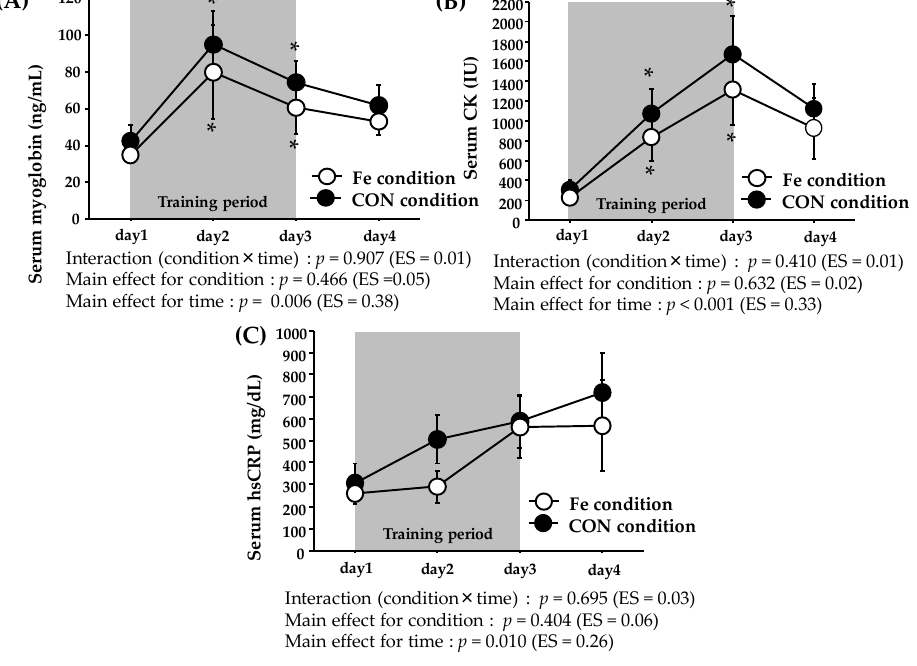
Figure 1. Serum myoglobin ( A ); CK ( B ); and hsCRP ( C ) levels on days 1–4. The values are means ± SE. * Significant difference from day 1.